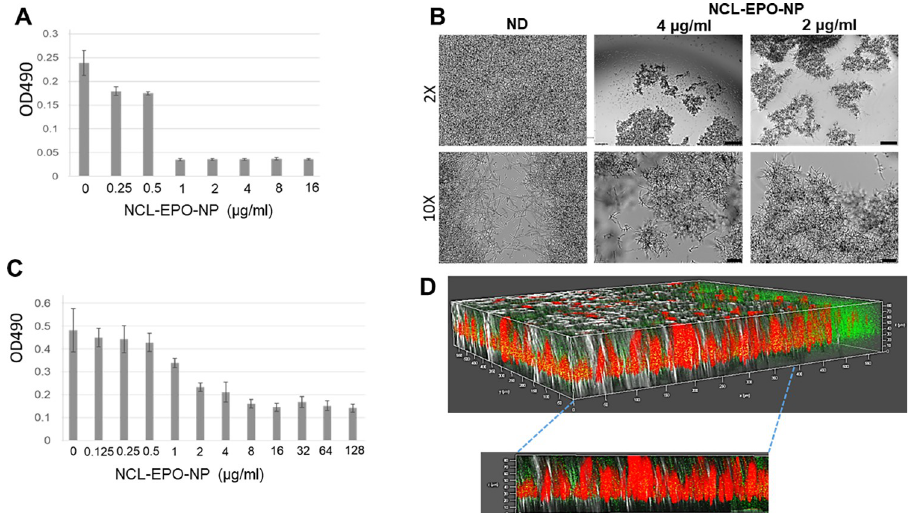
Fig 6. NCL-EPO-NP abrogate C . albicans biofilm growth. (A) Addition of NCL-EPO-NP at the beginning of C . albicans biofilm induction (96-well flat well microtiter plates) arrested biofilm growth at 1 μ g/ml. (B) NCL-EPO-NP added on to preformed biofilms induced biofilm detachment at 2 μ g/ml, which was visualized microscopically. Scale bar for 2X mag is 500 μ m, and for 10X is 100 μ m. (C) The effect of the NP on preformed biofilms was quantified by XTT assay, which revealed a > 50% reduction in biofilm metabolic activity starting at 2 μ g/ml. (D) Coumarin-tagged NCL-EPO-NP (green) could efficiently penetrate the concanavalin-stained C . albicans biofilm (red), as seen by the yellow-stained particles (green+red overlap). Raw data are found in the file S1 Data. NCL-EPO-NP, NCL-loaded EPO